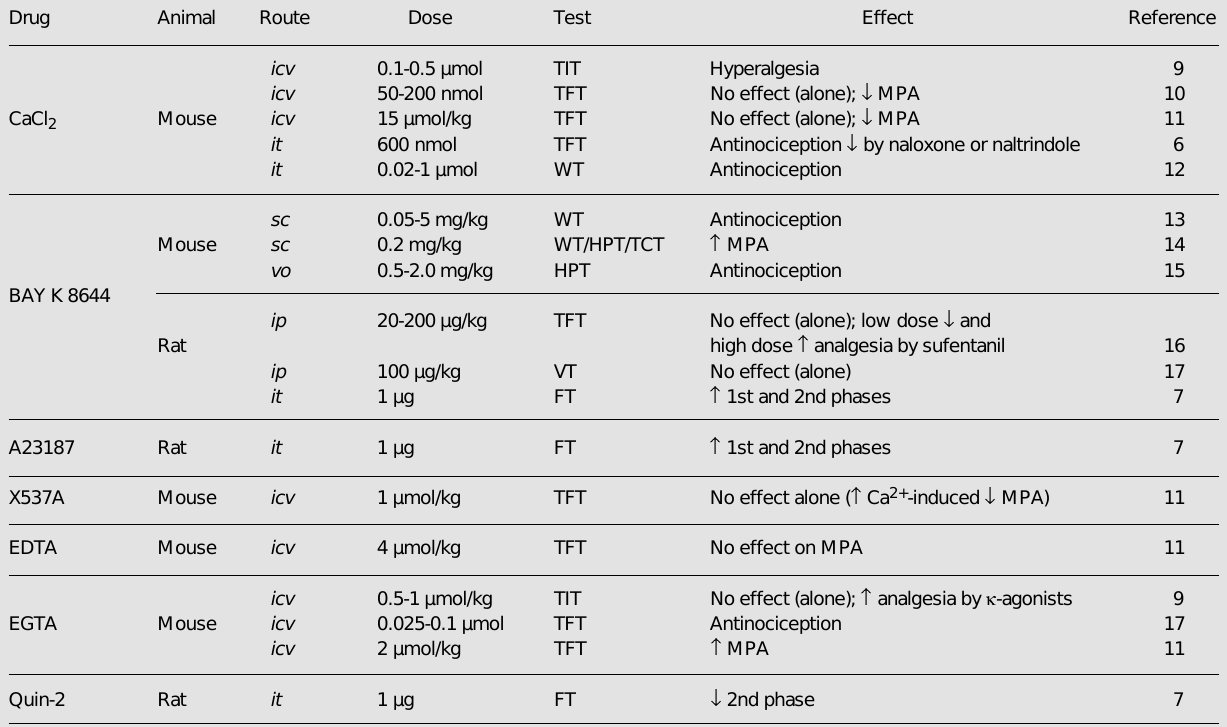
Table 2 - Effects of Ca 2+ , a Ca 2+ agonist, Ca 2+ ionophores or Ca 2+ chelators on nociception and opioid-induced antinociception. icv = Intracerebroventricular; it = intrathecal; sc = subcutaneous; vo = oral; ip = intraperitoneal; FT = formalin test; HPT = hot-plate test; TCT = tail- clamp test; TFT = tail-flick test; TIT = tail-immersion test; VT = vocalization test; WT = writhing test; MPA = morphine-induced analgesia. › = Increase; fl =